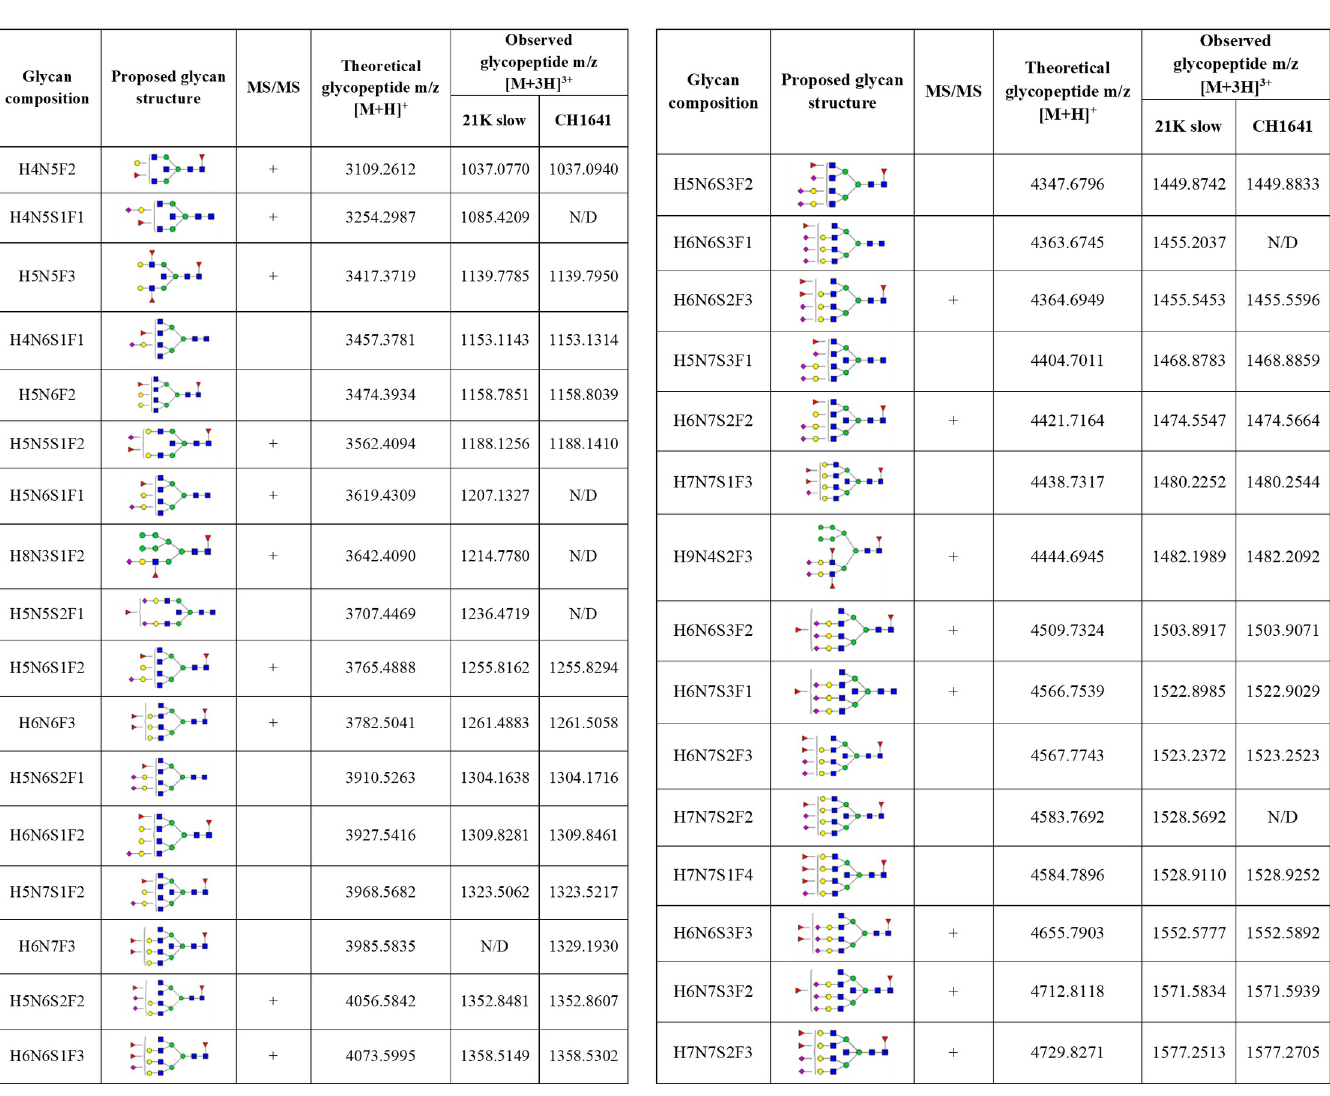
Fig 6. Identified N-200 glycopeptides on both prion strains. Proposed glycan structures found on N-200 glycosylation site with the theoretical and observed m/z values of the detected glycopeptides. H–hexose, N– N -acetylhexosamine, F–fucose and S– N -acetylneuraminic acid (sialic acid). Blue square–N-acetylglucosamine (GlcNAc), green circle–mannose (Man), red triangle–fucose (Fuc), yellow circle–galactose (Gal), purple diamond–N-acetylneuraminic acid (Neu5Ac). The presence of MS/MS spectrum is indicated with +. N/D–not